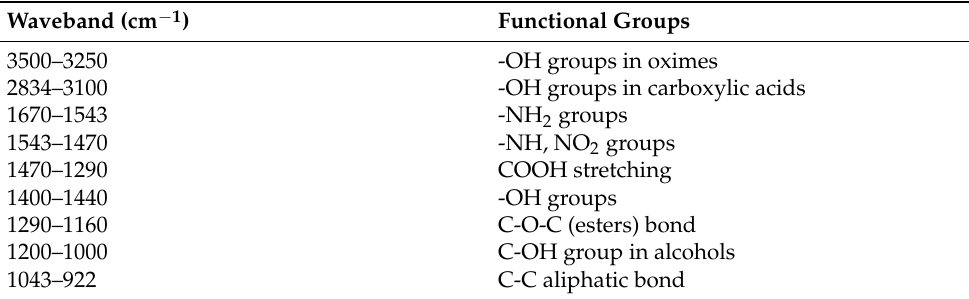
Table 5. Functional groups identified from Fourier Transformed Infrared (FTIR) spectra of biochar (BC) and treated biochar